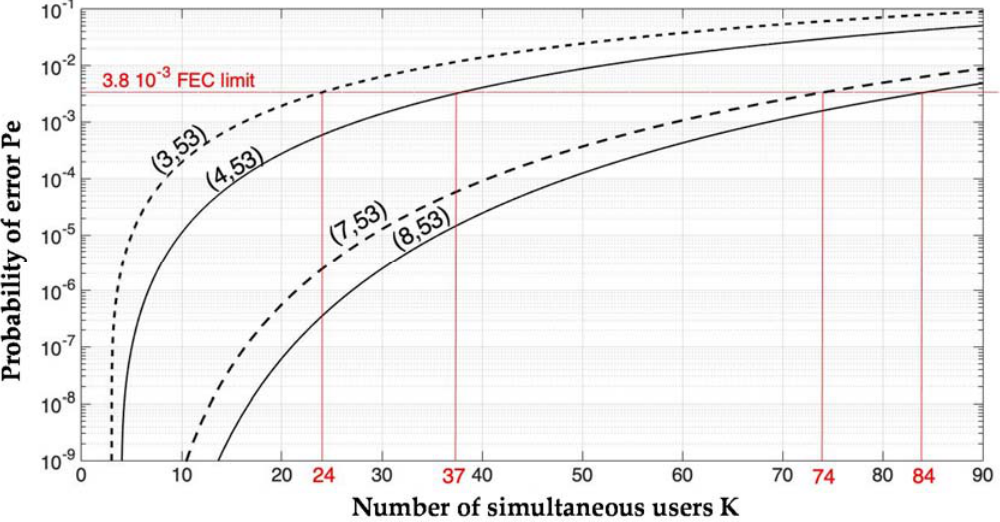
Figure 8. Probability of error as a function of K simultaneous users for a (4, 53) / (3, 53) and (8, 53) / (7, 53) 2D-WH / TS OCDMA system without / with the deployment of an SOA, respectively, the latter causing a one channel code carriers’ redshift.